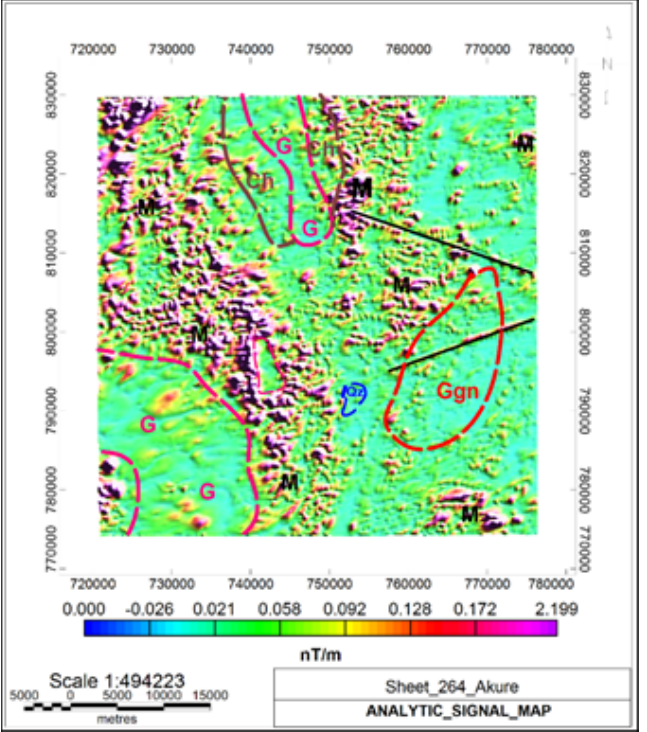
Figure 9: Analytic Signal (AS) Image produced to r Figure 11: Radially Averaged Power Spectrum (RAPS)/Spectral the study area show the litho- structures and trends in